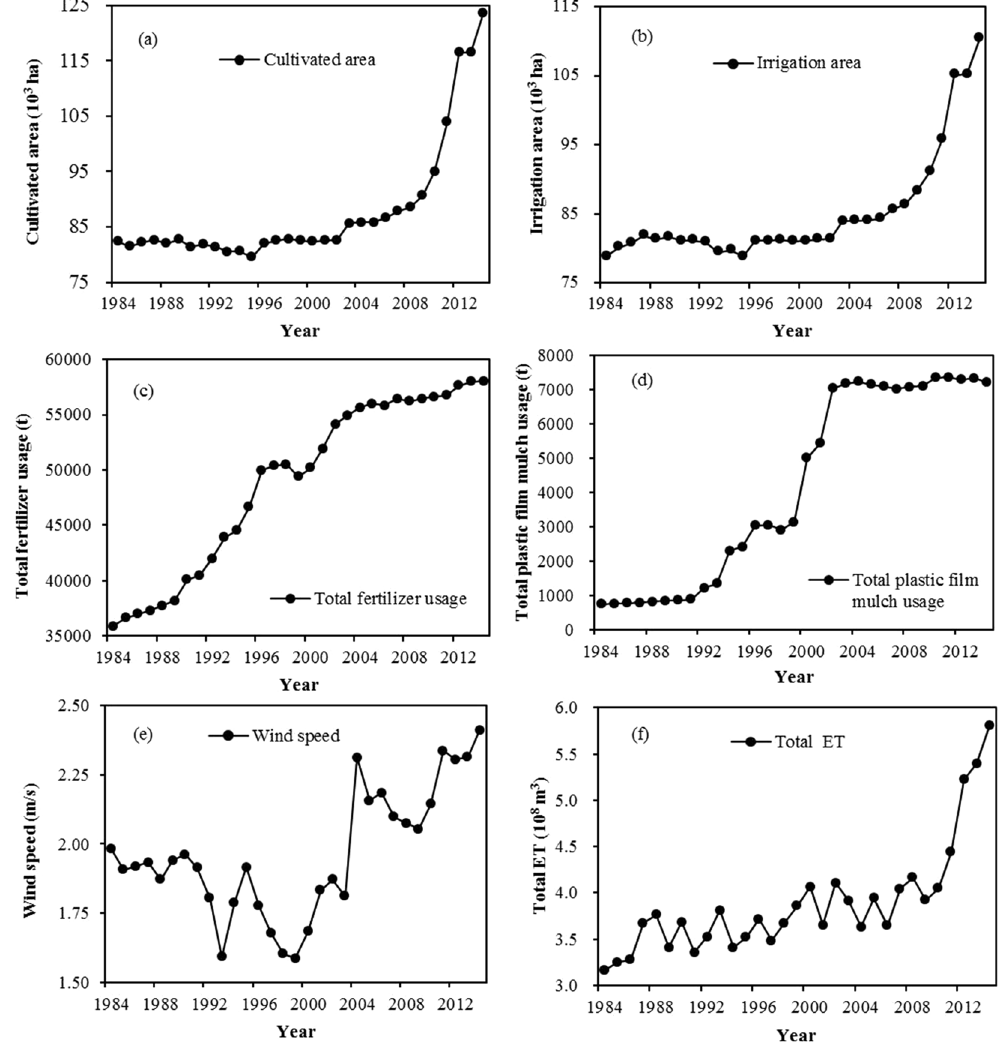
Figure 5. The change in average total ET for the entire agricultural region and the main driving